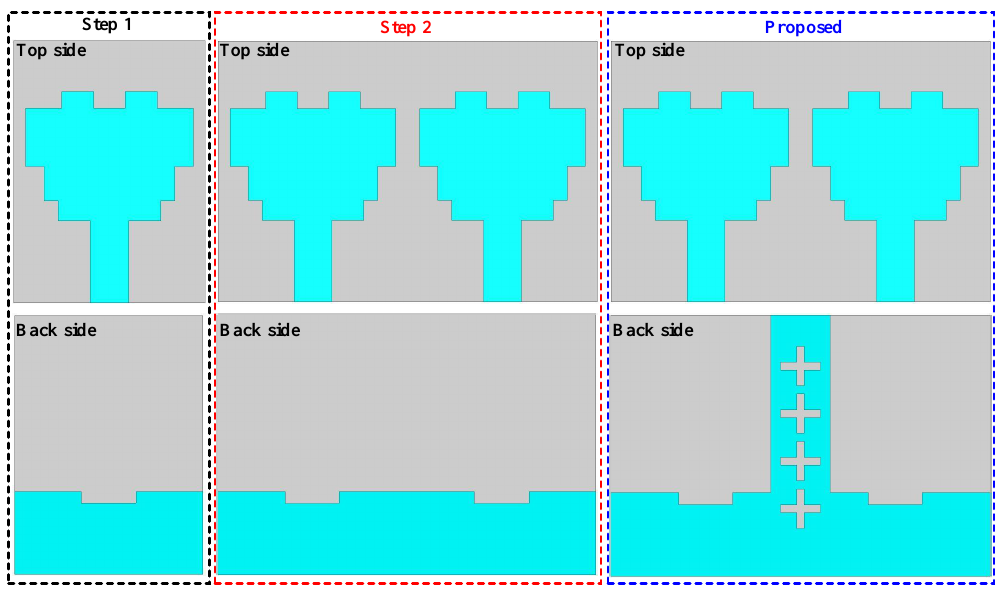
Figure 2. Design evolution stages of the proposed UWB-MIMO antenna.